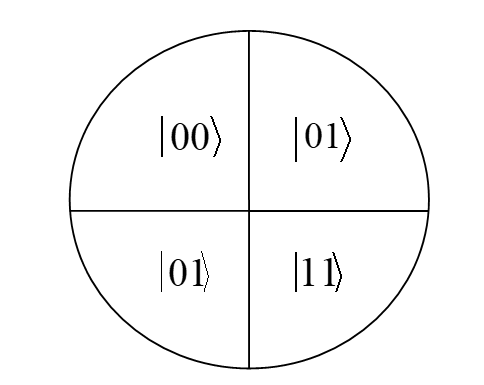
Figure 5. The N = 4 fuzzy